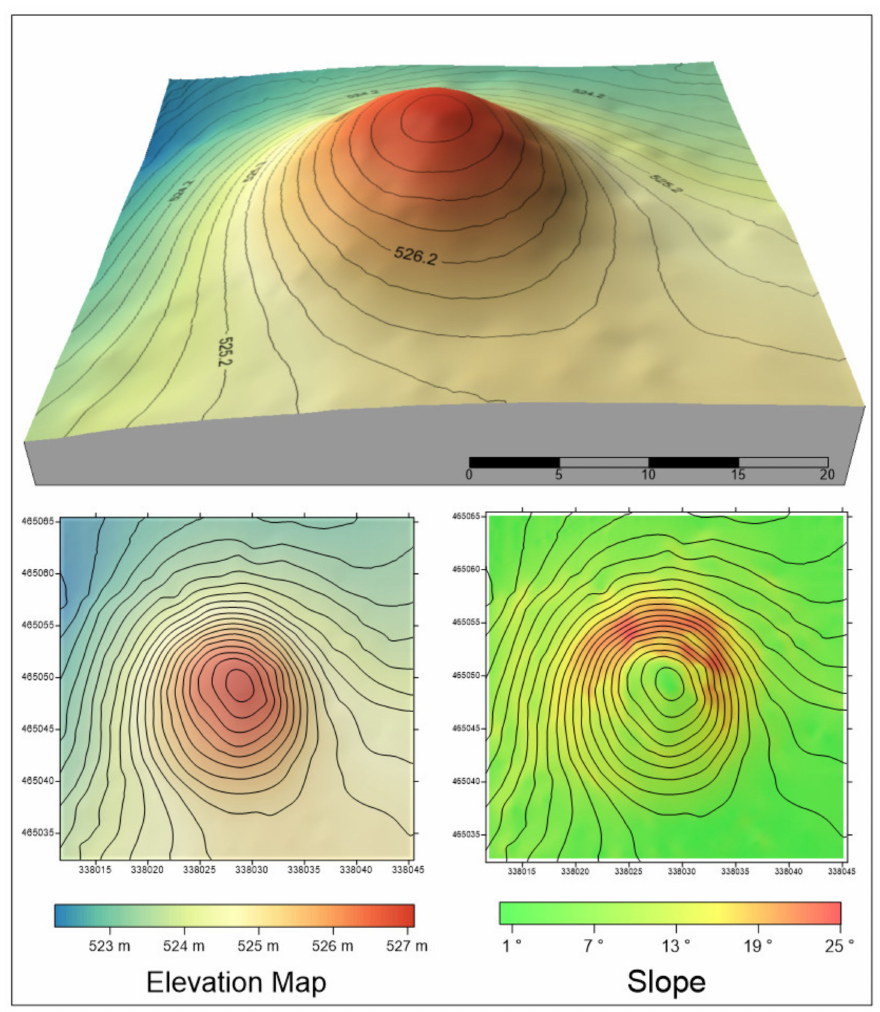
Figure 9. Basic morphometrical parameters of the mound: elevation model ( on the top ), elevation map ( bottom left ), and slope distributions ( bottom right